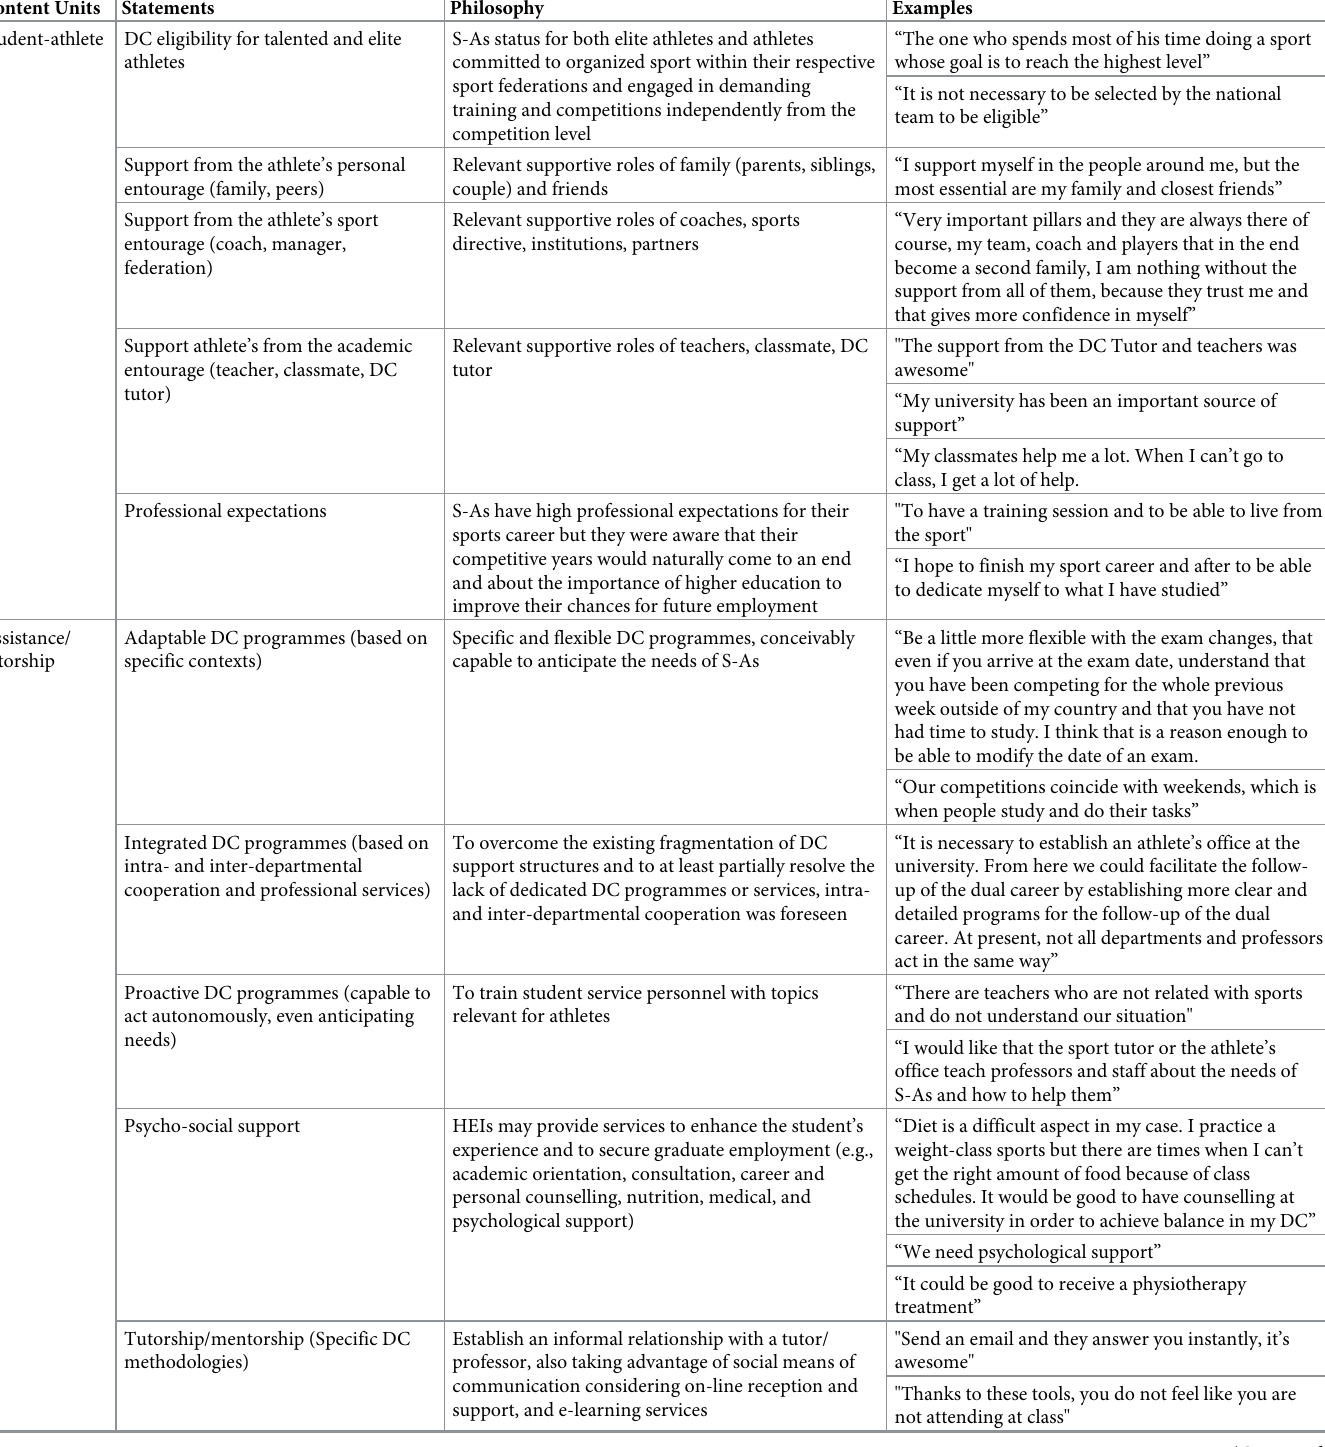
Table 2. List of statements to guide the development and/or implementation of dual career (DC) academic support and services Higher Educational Institutions (HEIs) for student-athletes (S-As). Content Units